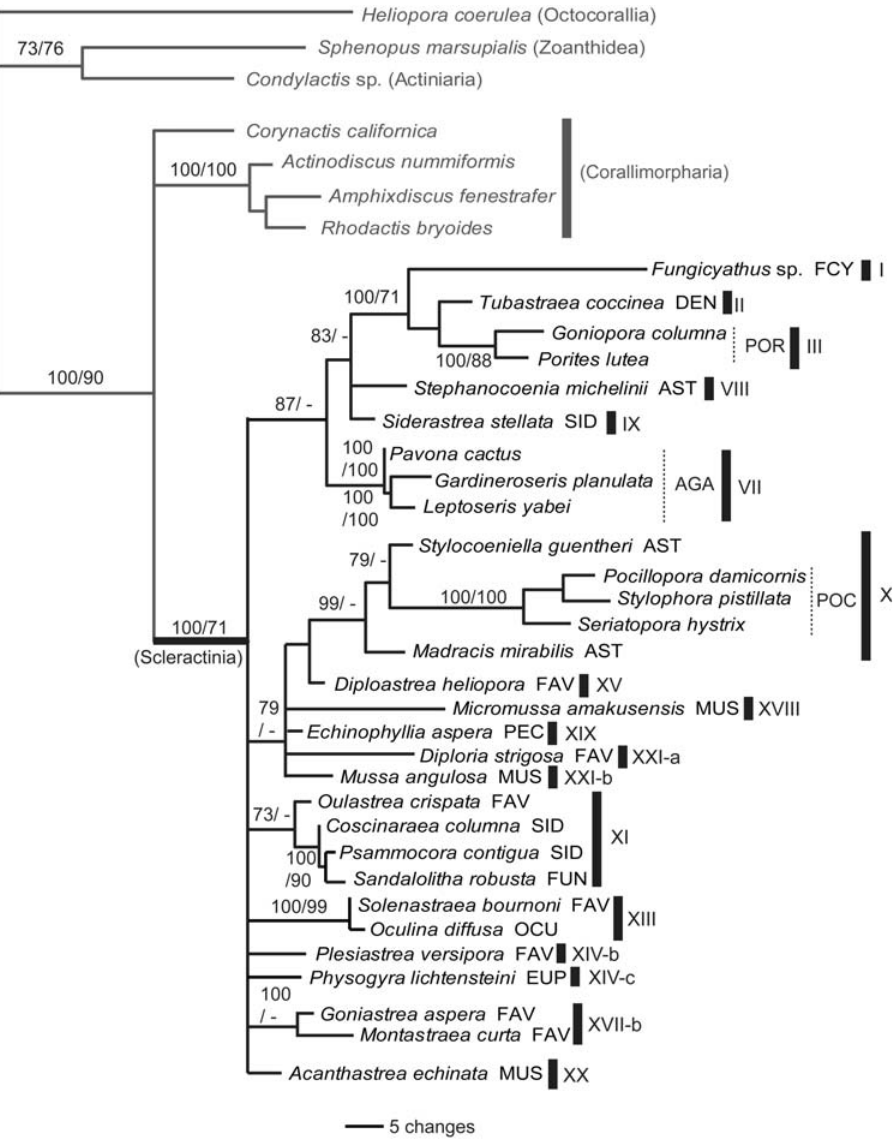
Figure 3. Bayesian tree based on the rDNA gene for a subset of the scleractinian corals analyzed in Fig. 1. Labeling conventions as in previous figures.